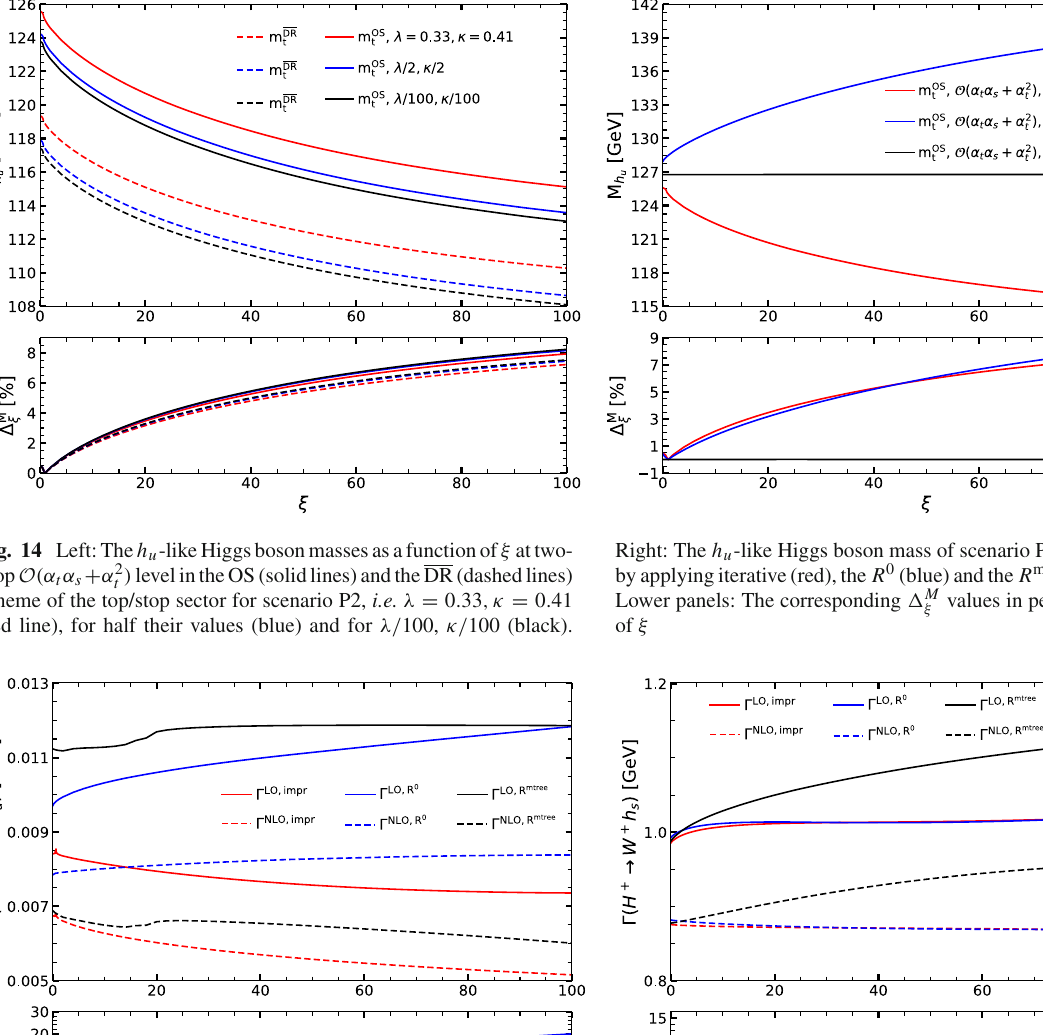
Fig. 15 P2: Decay widths for H ± → W ± h u (left uppper plot) and H ± → W ± h s (right uppper plot) as functions of ξ using the iterative (red), the R 0 (blue) and the R mtree method (black). Lower panels: Corresponding (cid:15) (cid:14) ξ in percent, as function of